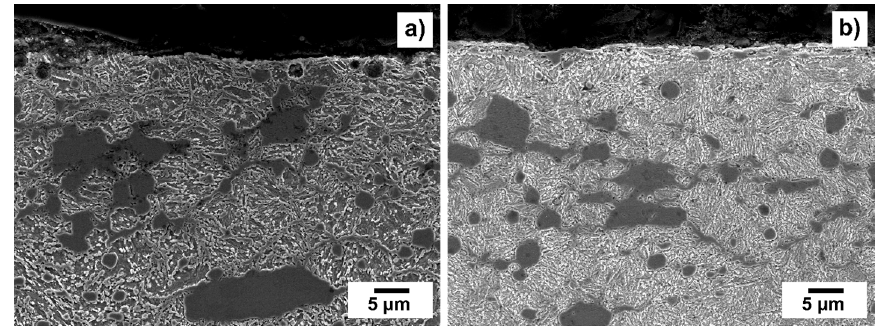
Figure 5. Details of X210Cr12 steel nitrided layer after: “B” treatment ( a ); and “D” treatment ( b ).